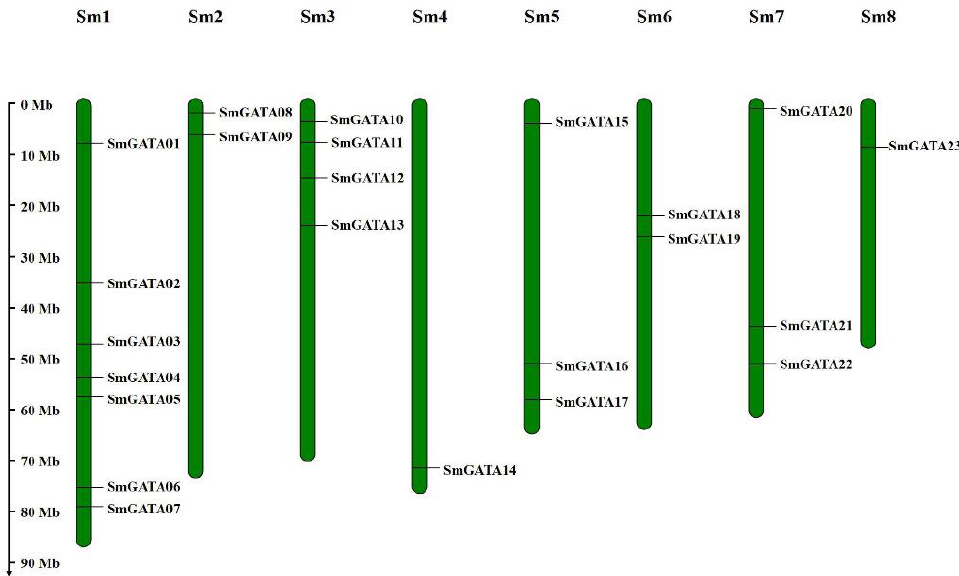
Figure 2. Chromosomal locations of SmGATA genes. The size of a chromosome was estimated from its relative length. The chromosome number are shown on the top of each chromosome.